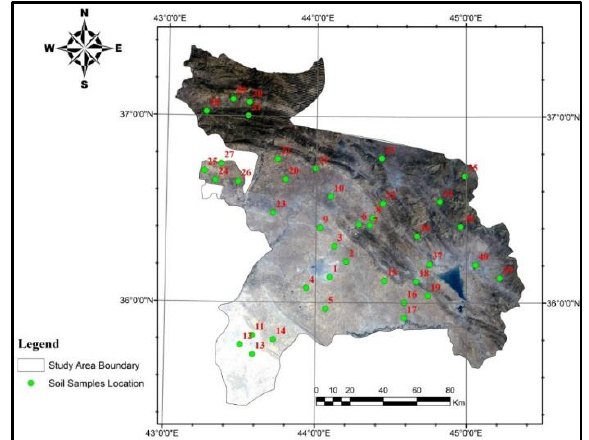
Figure 3. The map of the soil samples locations at the study